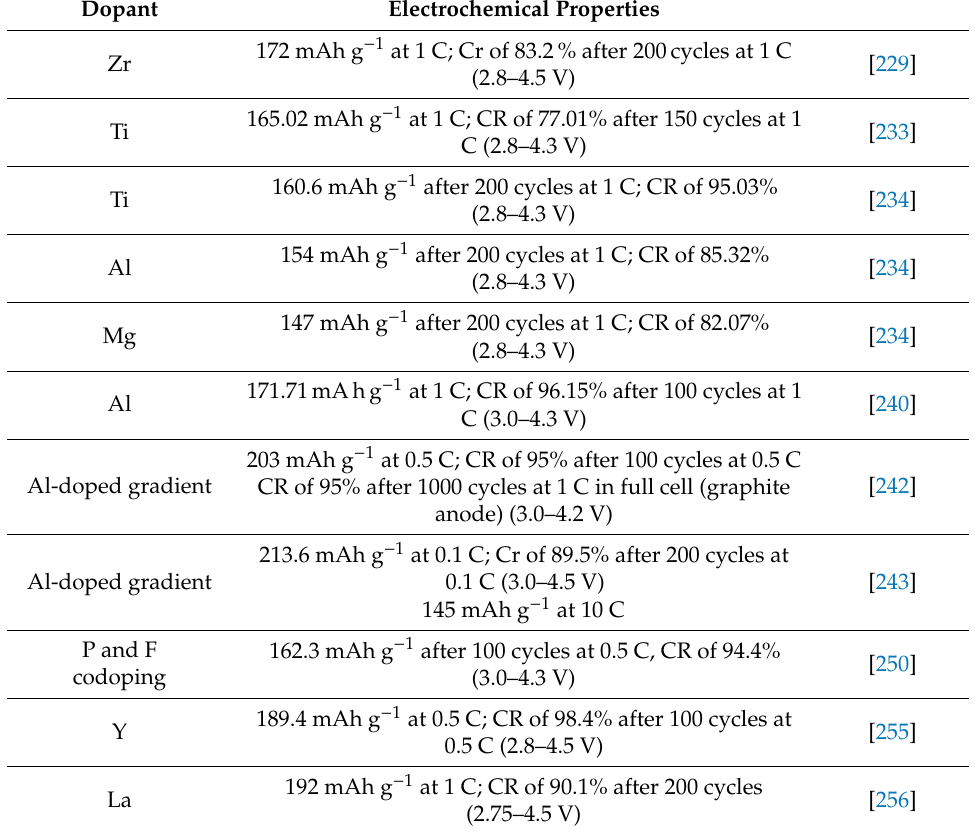
Table 4. Electrochemical properties of selected doped NMC811 (except Al concentration